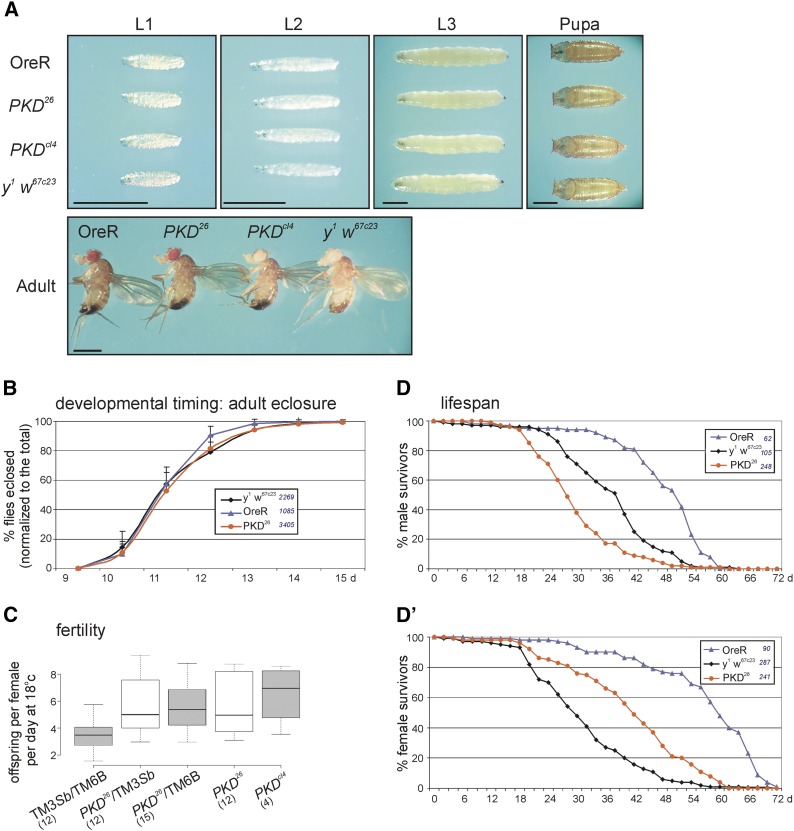
Phenotypic analyses of homozygous PKD mutant animals. (A) Comparison of control animals (OreR and y1 w67c23) with PKD26 and PKDcl4 mutant animal at first (L1), second (L2) and third (L3) larval stage, of pupae and of adult males. Typical examples are shown, no apparent size difference was observed. Scale bar is 1 mm in all panels. (B) Developmental timing: PKD26 mutants and control flies y1 w67c23 and OreR were reared under identical conditions at 25°C. Eclosion of adults was monitored over time (in days after egg deposition), and is shown as the fraction of the total number of animals (given in the legend). Four experiments were sampled: standard deviation is depicted as bars. Note similar timing of PKD26 mutants and controls (additional controls are within supplemental Figure S2). (C) Fertility of female flies is given as offspring per female per day at 18°C (n ≥ 12 experiments as indicated; PKDcl4 n = 4 experiments). Note similar fertility of homo- and heterozygous PKD mutants; doubly balanced flies produced least offspring. BoxPlots depict medians as Center lines; box limits indicate the 25th and 75th percentiles; whiskers extend 1.5 times the interquartile range. Sample points are given for each genotype in parentheses. Statistical analysis was performed with a two-tailed ANOVA test relative to TM3 Sb /TM6B using Dunnet’s approach (not significant). (D, D’) Lifespan of male and female control flies (OreR and y1 w67c23) vs. PKD26 mutant flies is depicted. Surviving flies over time (in days after egg deposition) is shown as fraction of the total (given in the respective legend). Whereas PKD26 males have a reduced life span (D), the PKD26 females live slightly longer than the control y1 w67c23 (D’). OreR flies live longest. See also supplemental Figure S3 for additional controls and statistics.